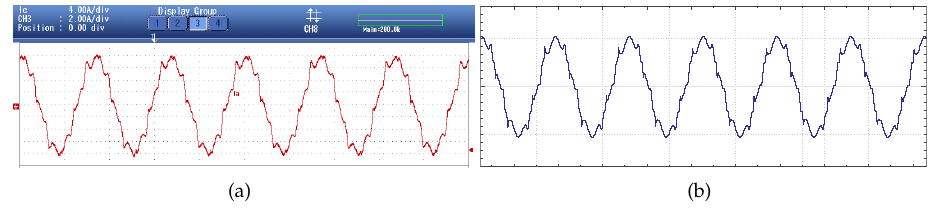
Figure 23. Grid current waveform for Case 2, THD = 10.8%: ( a ) measured current; ( b ) simulated